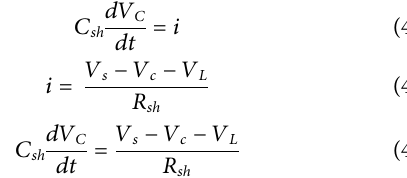
state (normal or steady-state operation) and off-state (grid fault scenario) is described as follows.